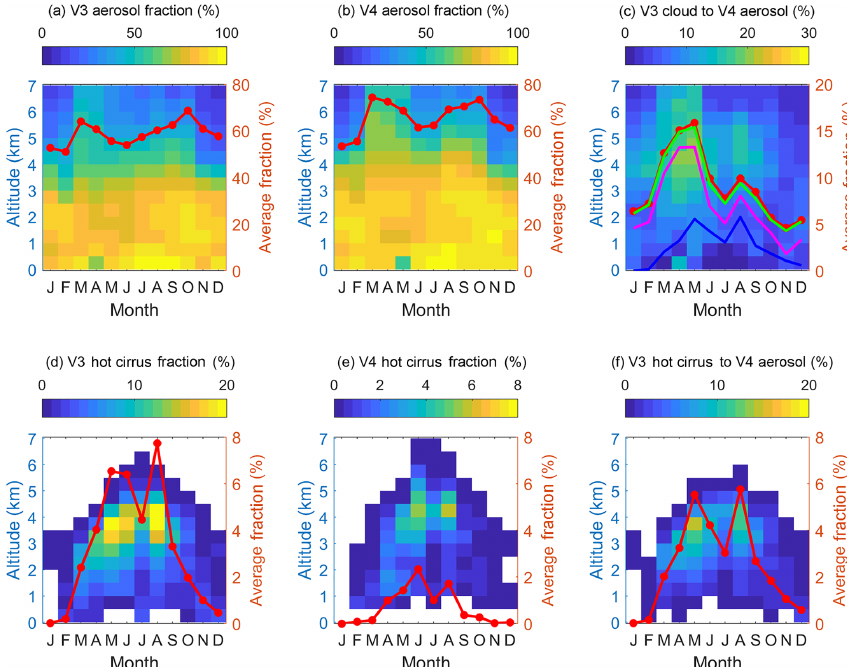
Figure 12. Seasonal variations in (a) V3 aerosol fraction, (b) V4 aerosol fraction, (c) fractions of V3 clouds changing to V4 aerosols, (d) V3 hot cirrus, (e) V4 hot cirrus, and (f) the fraction of V3 hot cirrus that changes to V4 aerosol in the Taklimakan region (35 to 45 ◦ N, 75 to 90 ◦ E). The fractions in panels (a) , (c) , (d) , and (f) are relative to the total number of V3 clouds and aerosols whereas the fractions in panels (b) and (e) are relative to the V4 total. The red curve in each panel is a column average fraction (%) between 0 and 7km. Additional information is provided in panel (c) , in which the blue curve shows the contributions from V3 hot cirrus and the magenta curve shows the contributions from all V3 ice clouds. The difference between the green and magenta curves quantifies the contributions of no-confidence clouds, while the difference between the red and green curves quantifies the (very small) contributions from V3 water clouds. In total, 29.6% of all V3 cloud-to-V4 aerosol changes were considered hot cirrus in V3. High-confidence ice clouds, low-confidence ice clouds, and water clouds contribute 47.1%, 19.2%, and 4.1%,